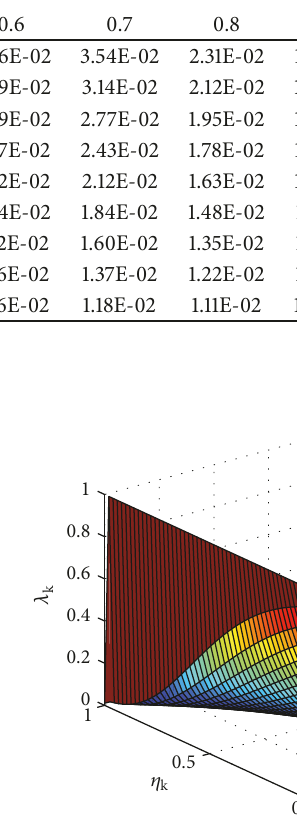
Figure 4: Effects of the health food safety information transparency 𝜃 and the degree 𝑘 of health food consumers’ ability to process information 𝜂 𝑘 on the health food safety scare behavior diffusion rate 𝜆 𝑘 when 𝜆 0 = 0.01 and 𝑘 = 1000